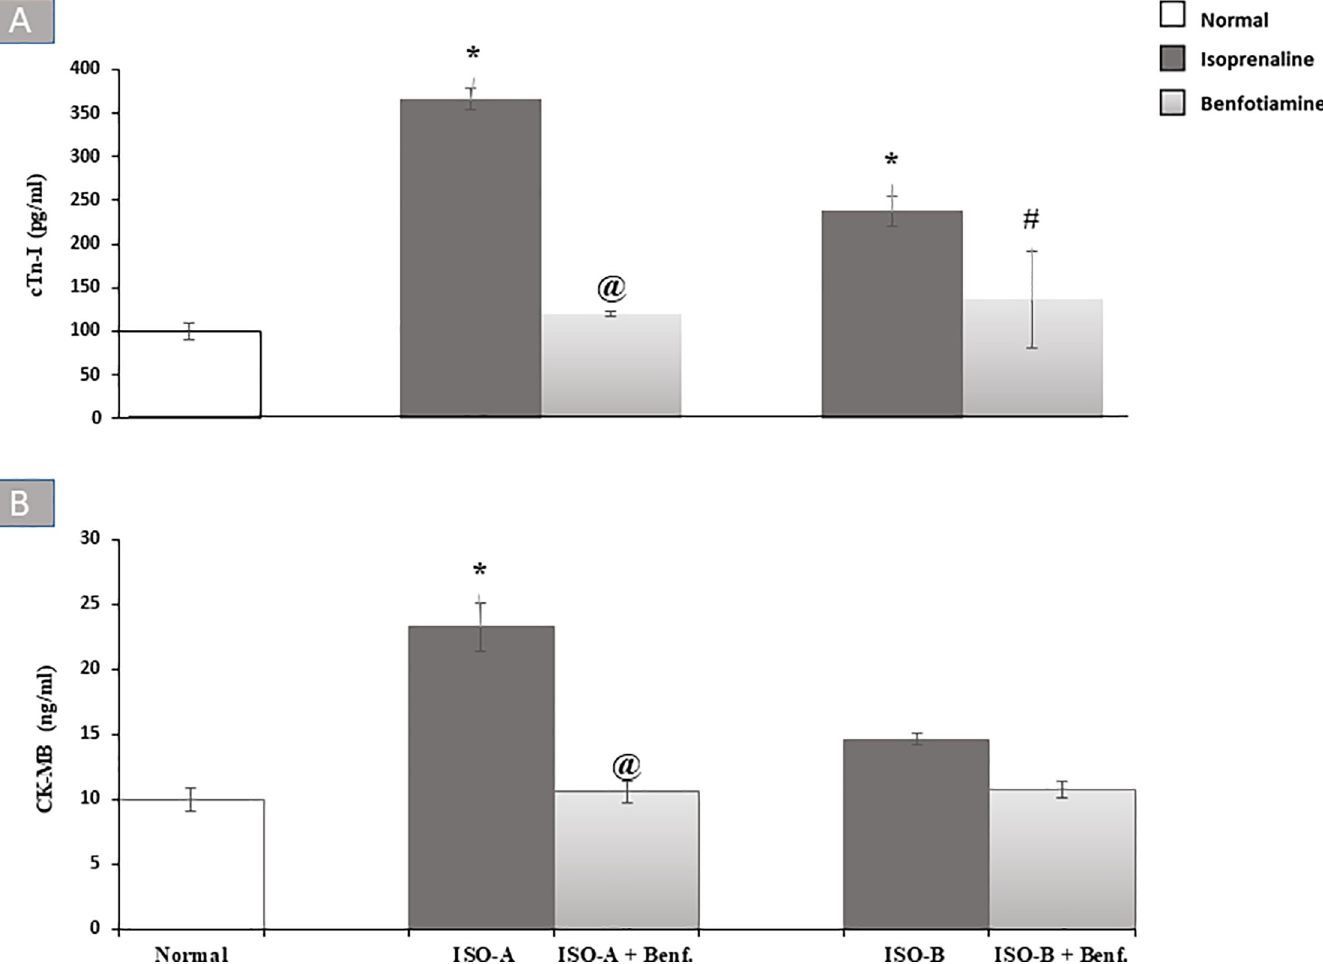
Fig 1. Effect of benfotiamine pre- and post-treatments on serum (A) cTn-I and (B) CK-MB levels in ISO-induced MI in rats. Each bar represents mean ± SEM (n = 8). Statistical analysis was done using One-way ANOVA followed by Tukey’s post-hoc test. � significantly different from the normal group at p < 0.05. @significantly different from the ISO-A group at p < 0.05. #significantly different from the ISO-B group at p < 0.05. ISO-A: ISO pre-treatment control; ISO-B: ISO post-treatment control; ISO-A + Benf.: benfotiamine prophylactic; ISO-A+ Benf.: benfotiamine treatment.